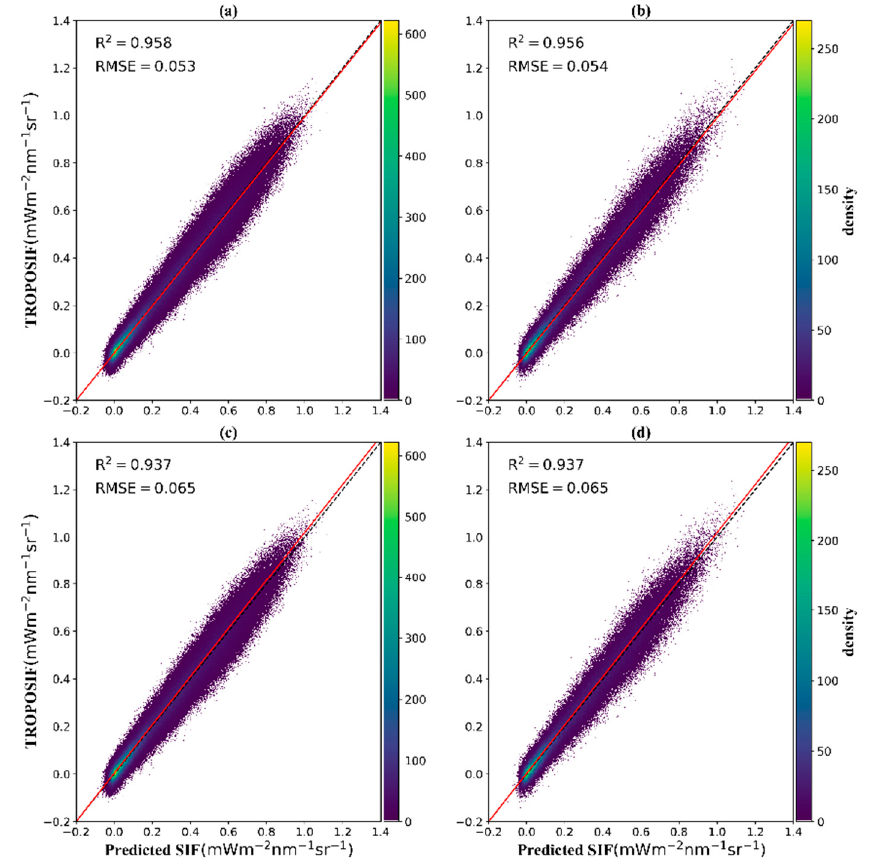
Figure 4. The scatterplots of TROPOSIF and predicted TSIF for training and validation; ( a , b ) for our local models and ( c , d ) for the universal model.